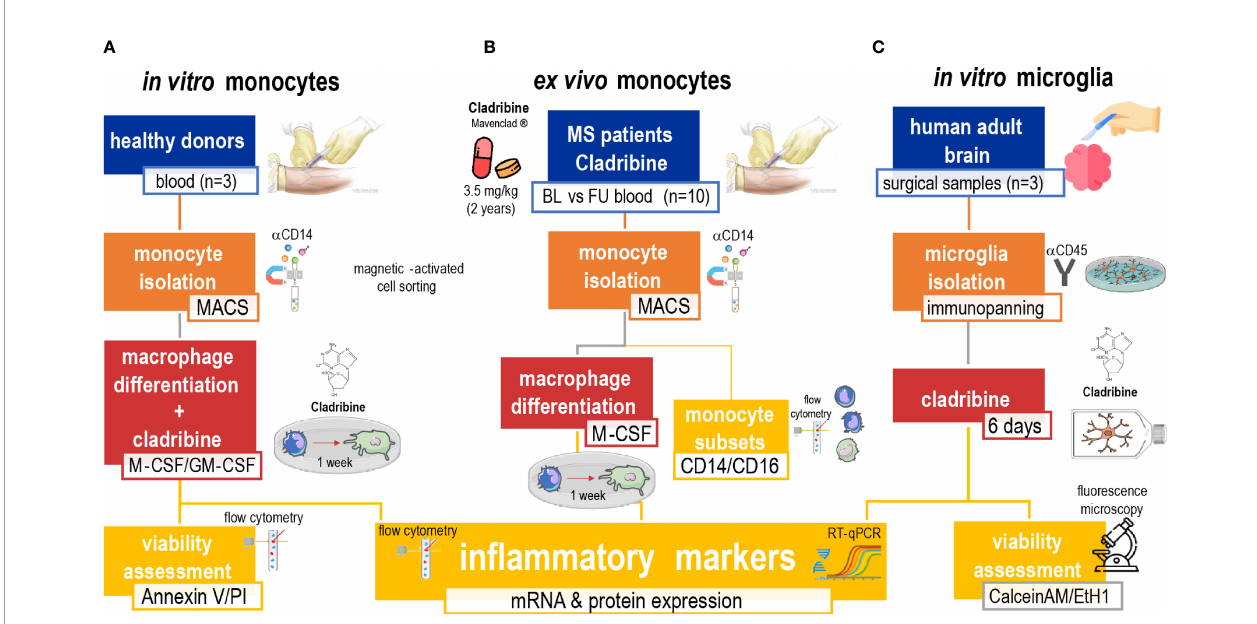
FIGURE 1 | Schematic of the experimental approach. The study was composed of three arms aimed to investigate the effects of cladribine in monocytes, monocyte-derived macrophages (MDMs) and microglia. The fi rst in vitro (A) approach comprised the isolation of monocytes from healthy donors ’ PBMCs by MACS, and M-CSF and/or GM-CSF-induced MDM differentiation. MDMs in differentiation were treated with cladribine for 6 days (total culture period of 7 days). Their viability was analyzed with the annexin V/PI assay by fl ow cytometry and their activation pro fi le was analyzed by fl ow cytometry and RT-qPCR. The ex vivo (B) approach comprised monocytes isolated via magnetic-activated cell sorting (MACS) from PBMCs of MS patients undergoing cladribine treatment. These monocytes were analyzed via fl ow cytometry and used to generate M-CSF-induced MDMs in vitro , whose activation pro fi le was further analyzed by fl ow cytometry and RT-qPCR. The second in vitro (C) approach comprised the isolation of microglia from adult surgical brain samples from patients with temporal lobe epilepsy by immunopanning. Microglia were then treated with cladribine for 6 days. Their viability was assessed by fl uorescence microscopy with calcein AM and ethidium homodimer-1 staining, and their activation pro fi le was analyzed by fl ow cytometry and RT-qPCR. Blue: origin of cells. Orange: isolation technique. Red: in vitro culturing and treatment. Yellow: analysis. MS, multiple sclerosis; MACS, magnetic-activated cells sorting; M-CSF, macrophage colony-stimulating factor; GM-CSF, granulocyte-macrophage colony-stimulating factor; RT-qPCR, quantitative reverse transcription-polymerase chain reaction; PI, propidium